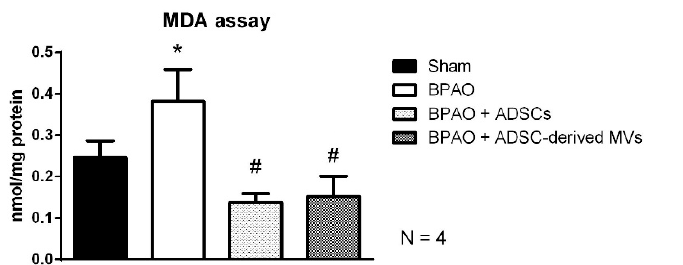
Figure 10. MDA assay in separated group. Figure 10 showed BPAO group had significantly higher level of MDA than sham group (* p < 0.05). The MDA level is lower in BPAO + ADSCs group and BPAO + ADSC-derived MVs group compared to BPAO group ( # p < 0.05).